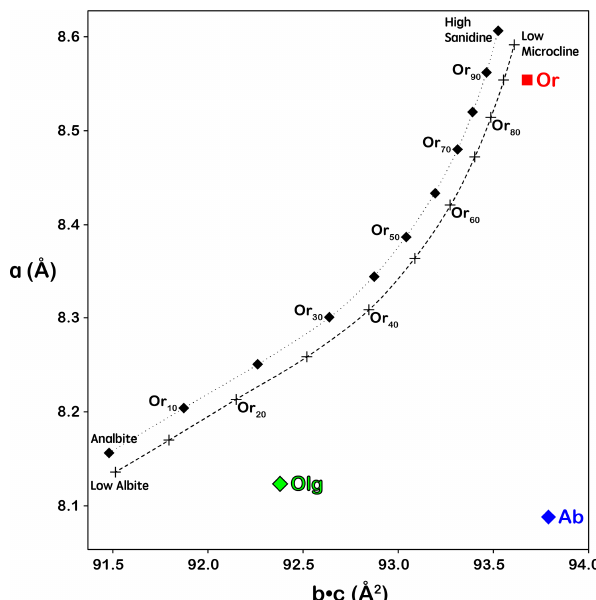
Figure 9. Lattice dimension a plotted against b × c as proposed by W. H. Bernotat (Kroll and Ribbe, 1983) to show lattice strains on the feldspar structure. Unstrained alkali feldspars would have lat- tice parameters plotted in the narrow band between the dotted and dashed curves. Strained albite in a perthitic intergrowth would fall to the lower right side of the band, and strained orthoclase would plot to the upper left side of the band. The orthoclase structure plot- ted slightly to the right of the unstrained band probably due to the celsian (Ba) component in the composition.